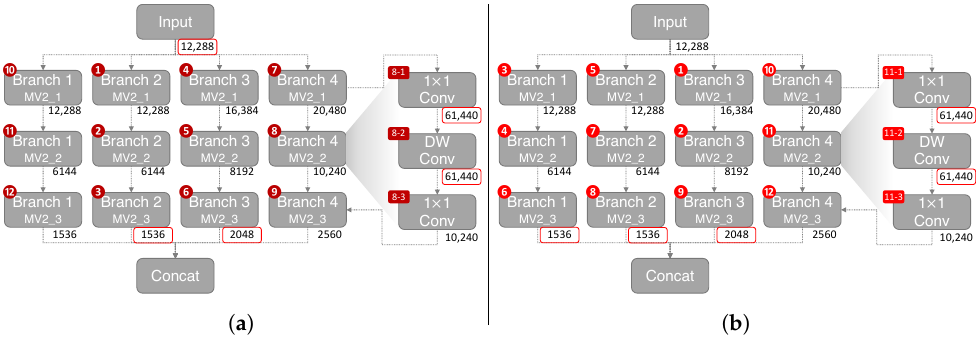
Figure 10. Demonstration of the difference between the order of operation. The red numbers labeled on the top left of each MV2 block indicate the order of operations. The numbers below the blocks indicate the tensors stored in memory in bytes during the peak memory operation. The sum of the tensors on memory demonstrates the peak memory. For a patch size 64 × 64, reordering the operations reduces peak memory by 11.4% . For illustration purposes, some orders have been simplified. ( a ) TensorFlow Lite default ordering (Peak memory: 135.5 kB). ( b )